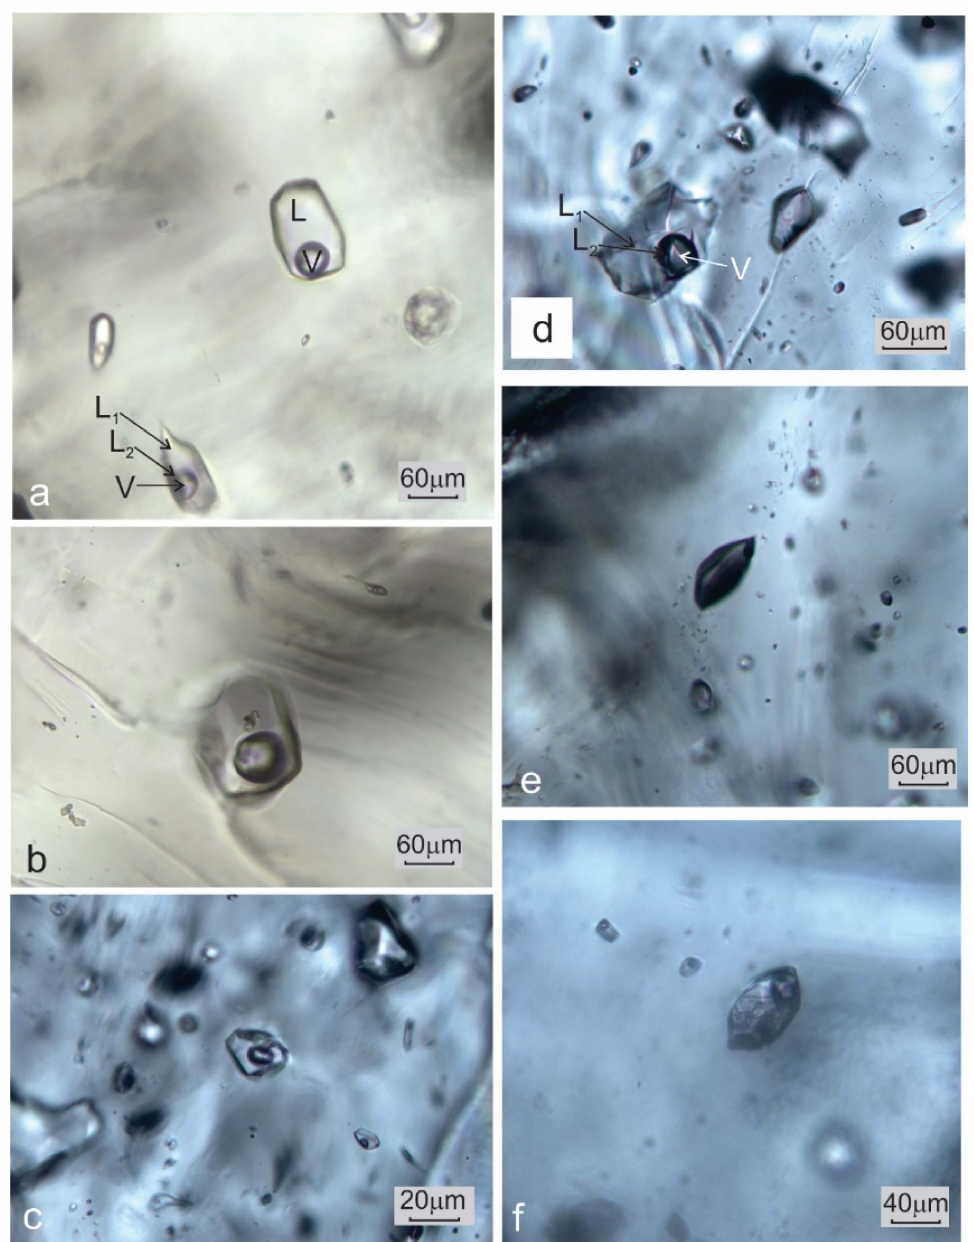
Figure 4. Macrophotographs of ( a ) coexisting two-phase, L + V, aqueous fluid inclusions and three-phase, L 1 + L 2 + V, aqueous-carbonic inclusions hosted by quartz; ( b ) two-phase, L + V, aqueous fluid inclusions seldom contain accidentally entrapped solid phases; ( c ) two-phase, L + V, aqueous fluid inclusions in microcline; ( d ) aqueous-carbonic inclusions in microcline; ( e ) a vapor-only inclusion hosted by